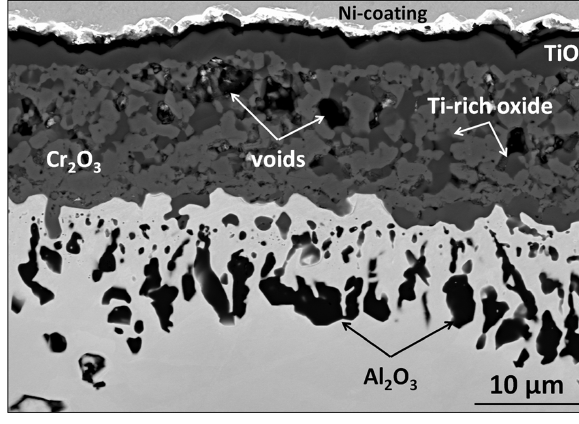
Figure 7: SEM/backscattered electrons(BSE) image showing the cross-section of Rene 80 after isothermal oxidation test at 1,050°C for 50 h in Ar – 20% O